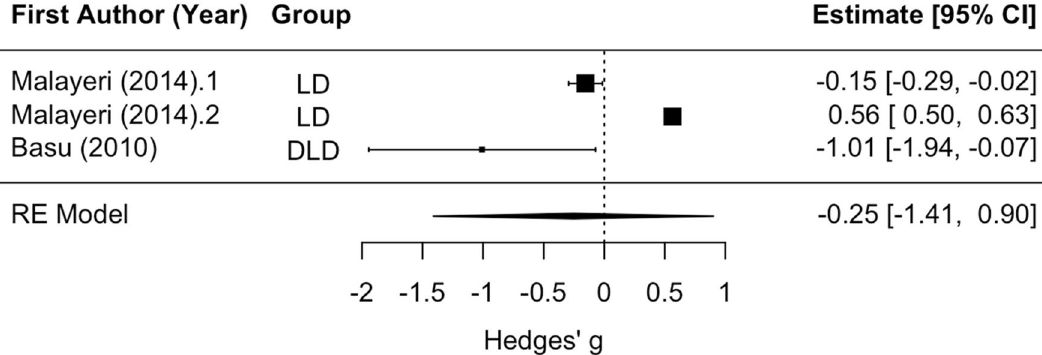
Figure 2. Wave I amplitude forest plot. Positive values for Hedges’ g indicate larger amplitude for the disorder group relative to controls. Rows with decimal points after the article year indicate multiple analyses from the same paper, and correspond to the row order of the analysis in the systematic review Supplement